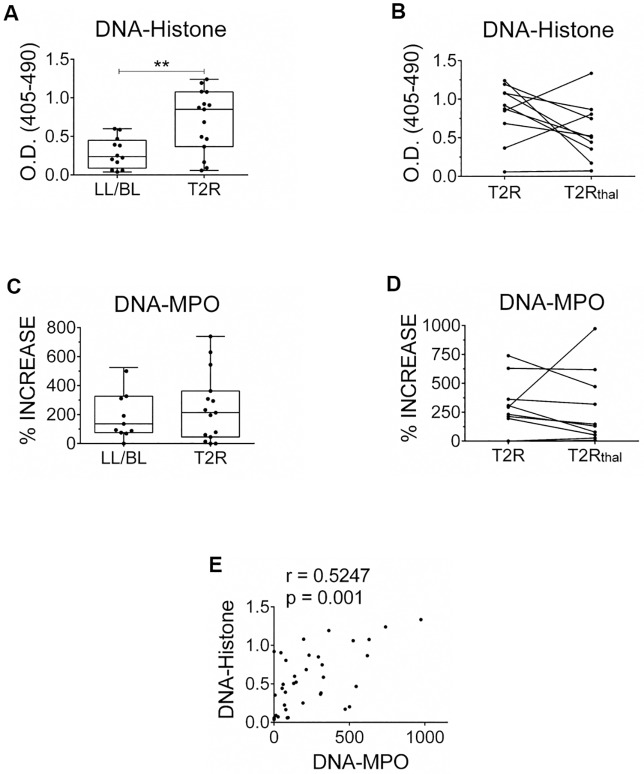
Circulating NETs components are higher in T2R patients, which decrease after thalidomide treatment.Patient serum samples were obtained; and the levels of the DNA-histone (A, B) and DNA-MPO (C, D) complexes were quantified by ELISA. DNA-MPO complex levels are expressed as percentages values above the blank. (B, D) Follow-up of the complexes serum levels during thalidomide treatment. Outliers were removed from analysis. Box plots show median, interquartile range, sample minimum, and maximum. Each dot represents a donor. **P<0.01 (Mann Whitney test). (E) Spearman’s correlation between DNA-histone and DNA-MPO complexes per patient (n = 36, r = 0.5247, P = 0.001).